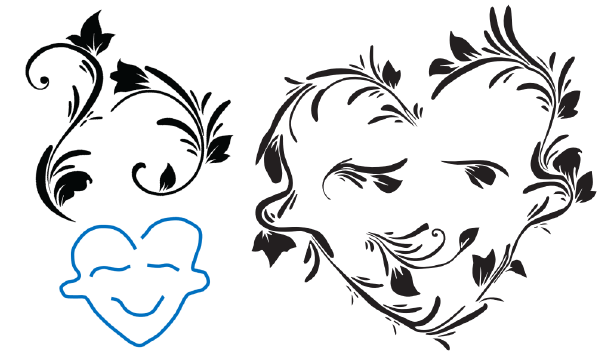
Fig. 14 Results from DecoBrush [77]. Reproduced with permission from Ref. [77], c (cid:13) Association for Computing Machinery, Inc.